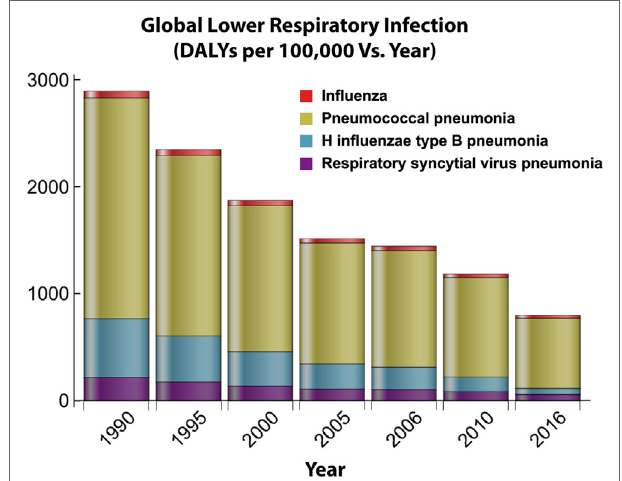
FigURe 6 | Global distribution of lower respiratory infections over time. This figure depicts how the burden for four major lower respiratory infections changes over time in response to the introduction of antibiotic treatments and vaccine implementation. Disability adjusted life year (DALY) data obtained from Institute for Health Metrics and Evaluation